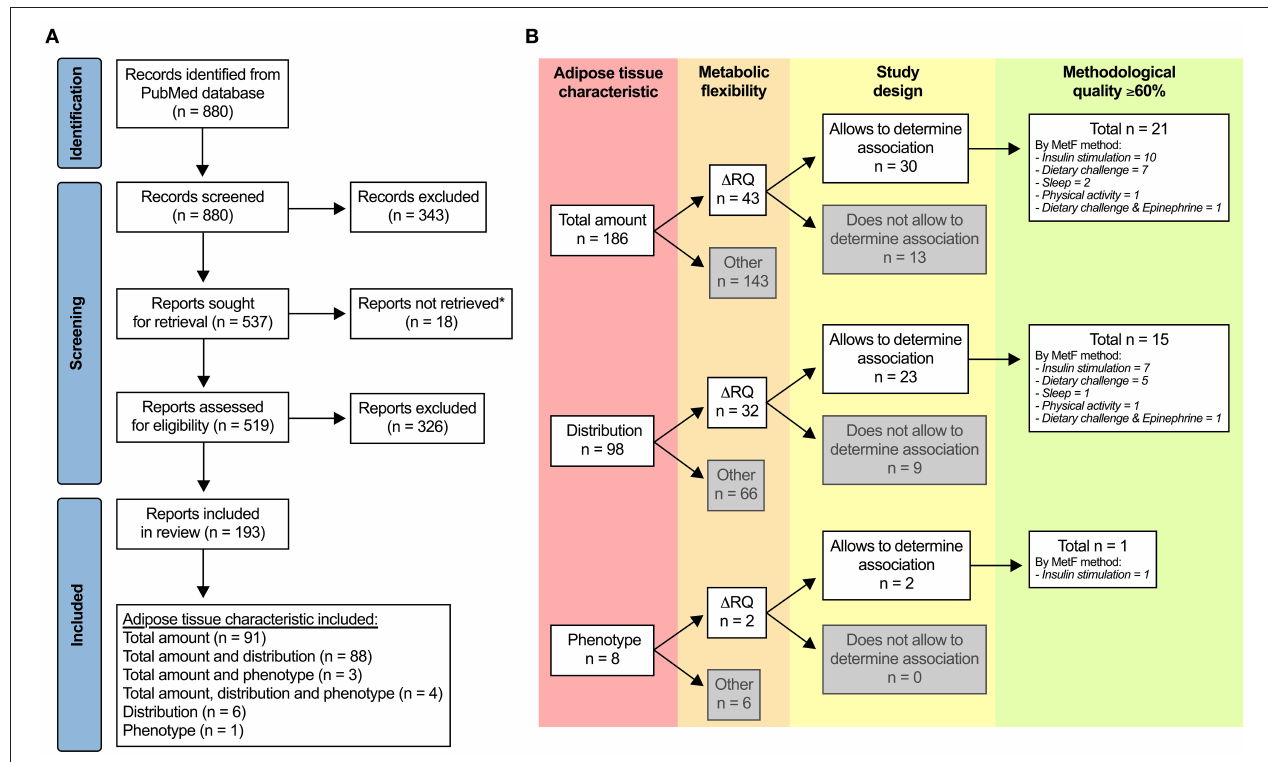
FIGURE 1 | Selection of studies. (A) PRISMA flow diagram. *Unavailable for download in PubMed, ResearchGate (including a request to the authors), or other online websites. (B) Additional criteria to identify the most relevant evidence regarding the association between adipose tissue characteristics and metabolic flexibility (MetF). 1 RQ, change in respiratory quotient in response to a metabolic